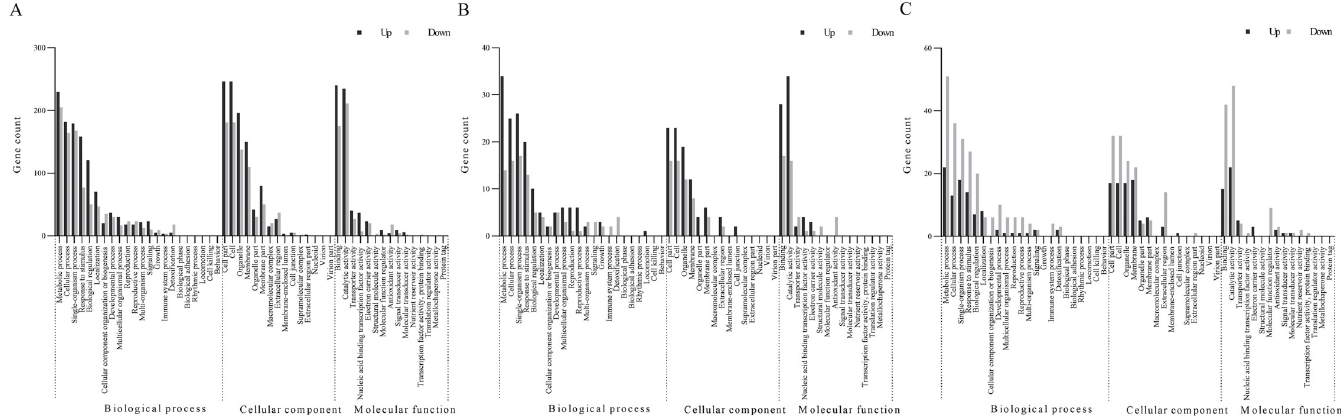
Fig 4. GO analysis of DEGs in the roots of the high-saline root side (200–0/200) ( A ), of the nonsaline root side (0–0/200) ( B ) and in the uniform salinity treatment (100–100/100) ( C ), as determined by RNA-seq. The abscissa of the bar plot represents the gene count within each GO category. All processes listed presented enrichment when P <